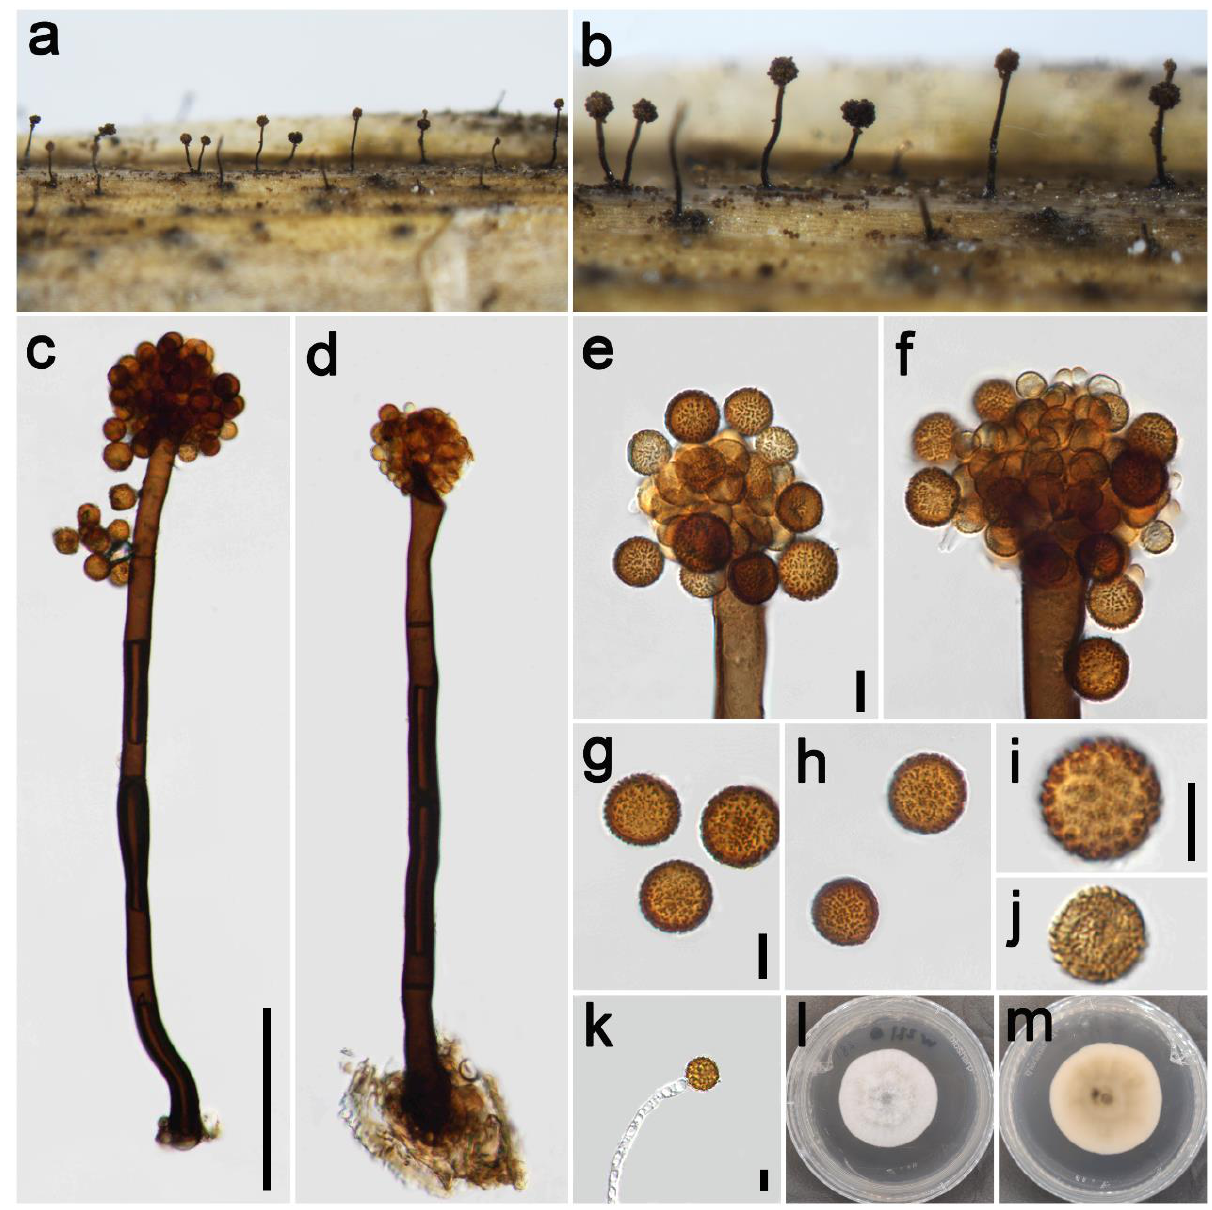
Figure 2. Periconia byssoides (HUEST 22.0133). ( a , b ) Colonies on the natural substrate; ( c , d ) conidio- phores with spherical conidial heads; ( e , f ) conidial heads bearing conidiogenous cells and conidia; ( g – j ) conidia; ( k ) germinating conidium; ( l , m ) colony on PDA from above and below. Scale bars: ( c ) = 100 µ m, ( e , g , k ) = 10 µ m. Scale bar of ( c ) applies to ( d ). Scale bar of ( e ) applies to ( f ). Scale bar of ( g ) applies to ( h ). Scale bar of ( i ) applies to ( j ).